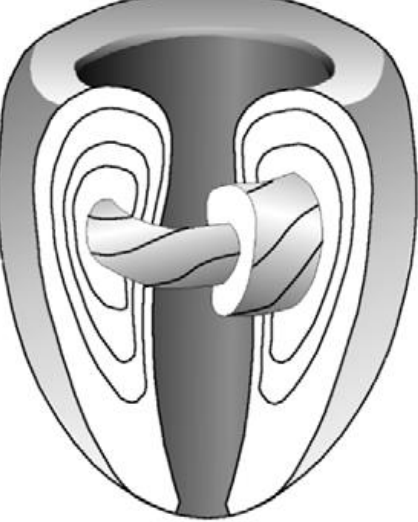
Figure 7. Sketch of the Streeter model “fibres run like geodesics on a nested set of toroidal bodies of revolution” (after 16). One of the consequences of Streeter ’ s model that was often left aside is that the toroi- dal model weakens the “double spiral” mod el of cardiomyocytes in the LVW, since it is only a direct sectioning artefact of the “geodesics on nested torus” model. This can be understood with a simpler model based on a single torus (Figure 5) and becomes more evident in a model built on nested tori . The “double spiral” appearance emerges from the sectioned view of the toroidal model.